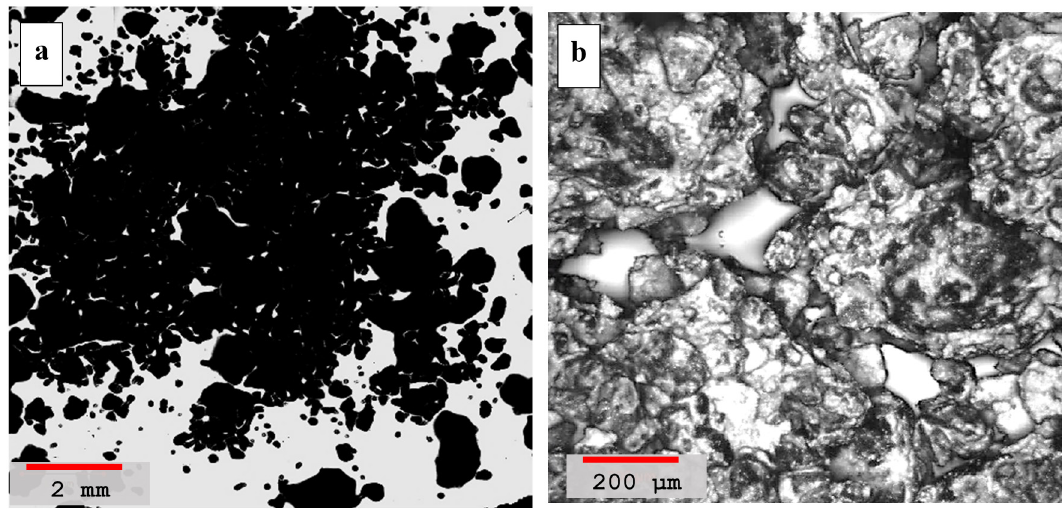
Figure 9. ( a ) Laser scanning microscopy images of hydrated and blended mortar containing a lime-to-ash ratio = 0.55, sample #e in Table 4, recorded at a lower 5 × magnification image (red color scale-bar shows ≈ 2 mm length). ( b ) Morphological image of the sample at higher magnification of a 50 × with scale-bar showing ≈ 200 µ m length.